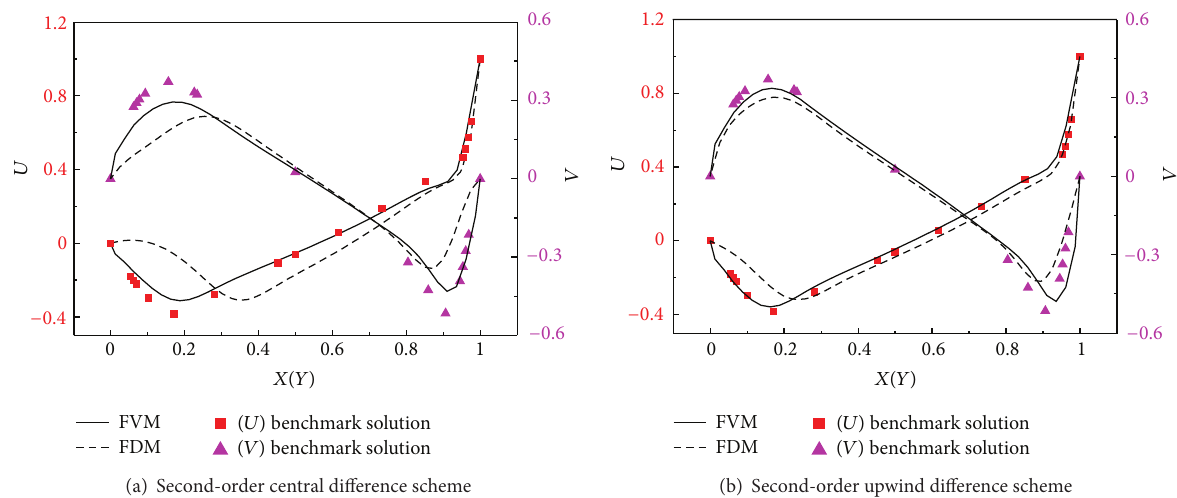
Figure 5: Velocity along the central axis obtained by vorticity-stream function method for lid-driven flow with different schemes when the mesh density is 40 × 40 .